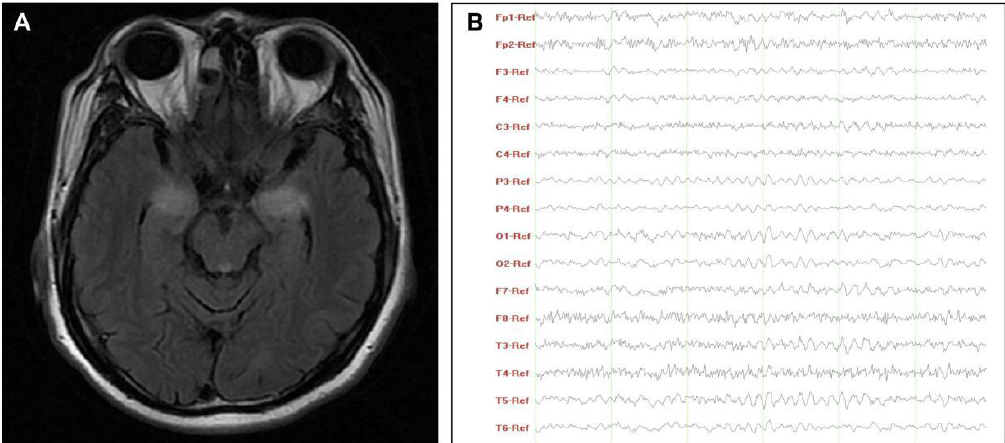
Figure 1. Characteristics of MRI ( A ) and EEG ( B ) of patient No.6. ( A ) T2-weighted images showed hyperintensity lesions on the bilateral mesial temporal lobe; ( B ) EEG revealed a widely diffuse distribution of theta waves with some low-amplitude fast activity. Abbreviations: EEG, electroencephalograms; MRI, magnetic resonance imaging.